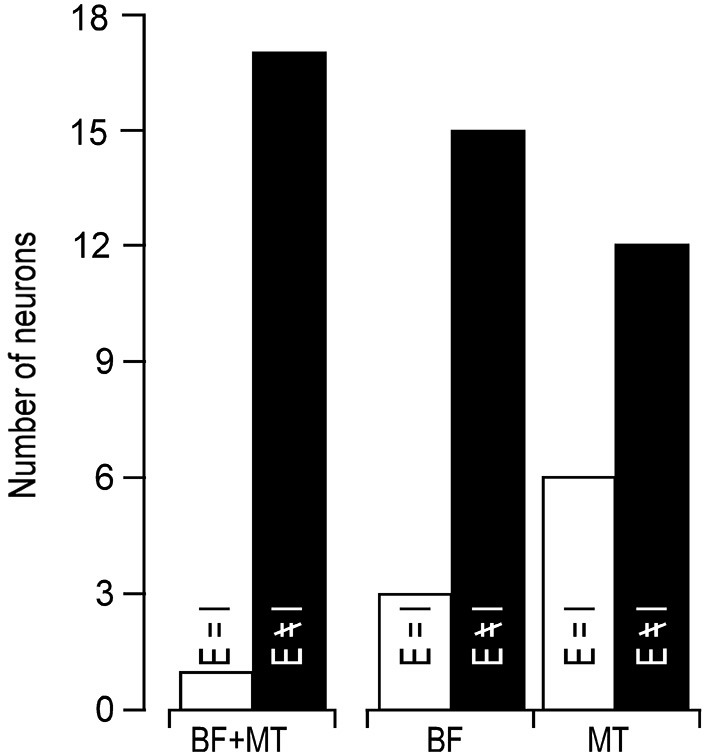
Number of neurons showing identical (open bars) and different (filled bars) BF/MT (left), BF alone (middle), MT alone (right) between EPSC and IPSC.